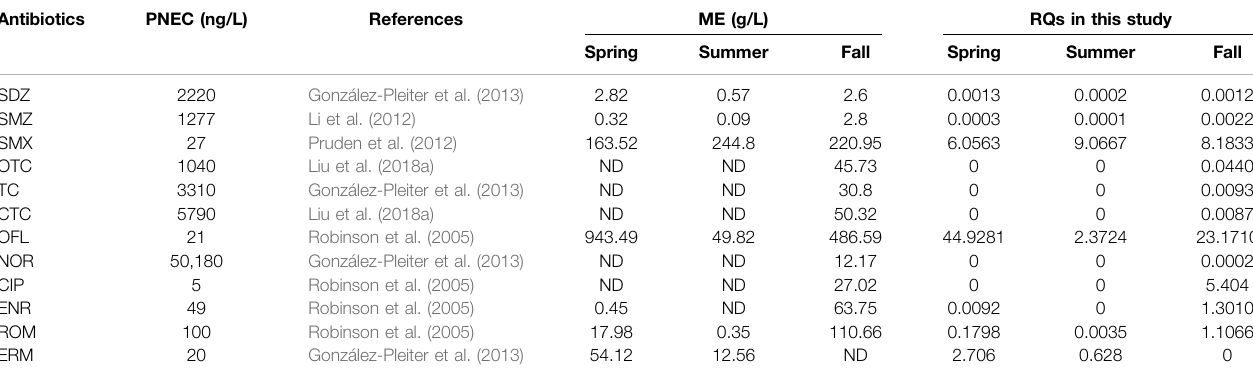
TABLE 3 | Ecological risk assessment parameters and RQs of antibiotics in East Dongting Lake water.